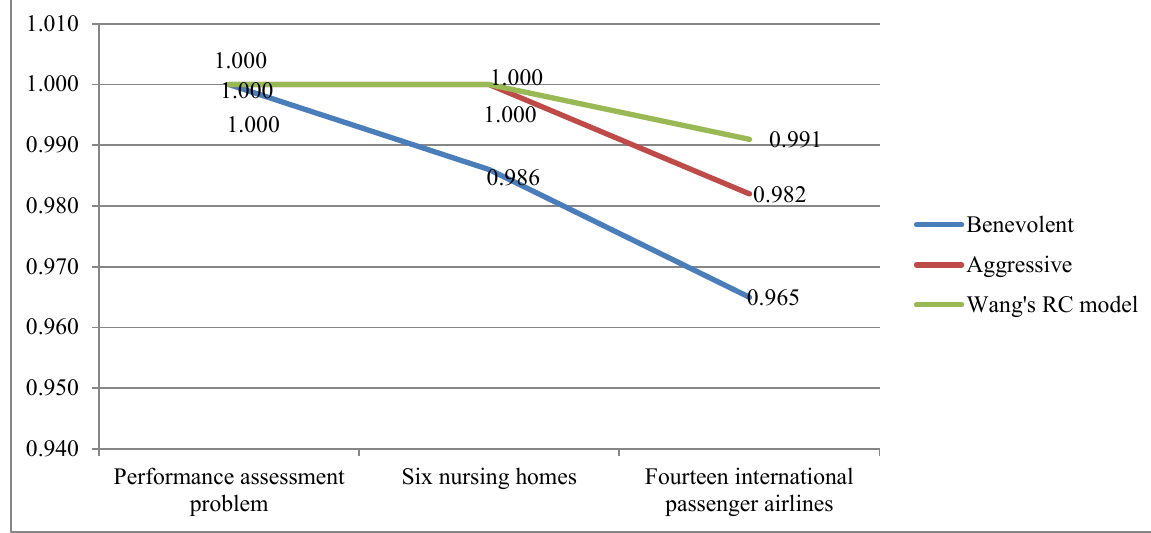
Fig. 2. Correlation coefficients of the proposed method and other